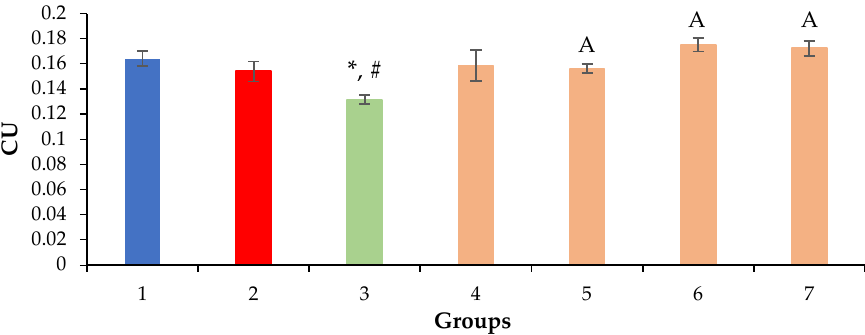
Figure 5. Volume density of hepatocyte nuclei. * p ≤ 0.05 as compared to the negative control; # p ≤ 0.05 as compared to the intact control; A p ≤ 0.05 as compared to silymarin 100 mg/kg. CU: conventional units; 1: intact control; 2: negative control; 3: positive control; 4: mice treated with QS-528 at a dose of 60 mg/kg; 5: mice treated with QS-528 at a dose of 90 mg/kg; 6: mice treated with QS-528 at a dose of 120 mg/kg; 7: mice treated with QS-528 at a dose of 150 mg/kg.